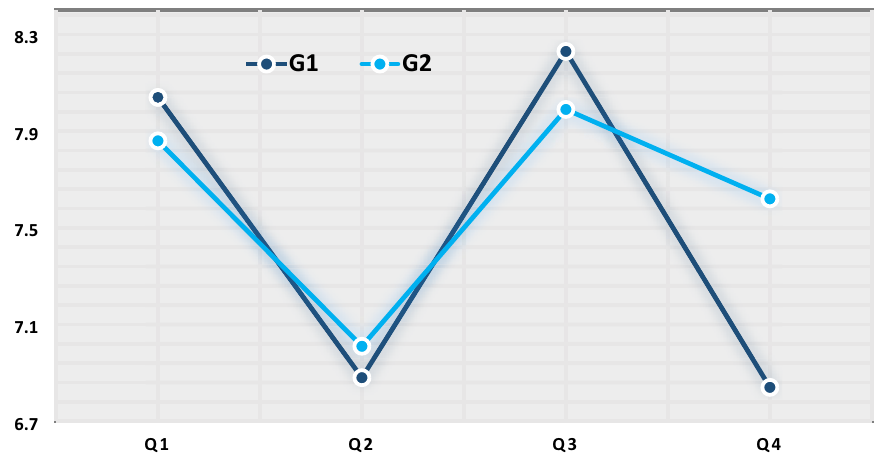
Fig. 2 Between-group comparison of post-test content recall